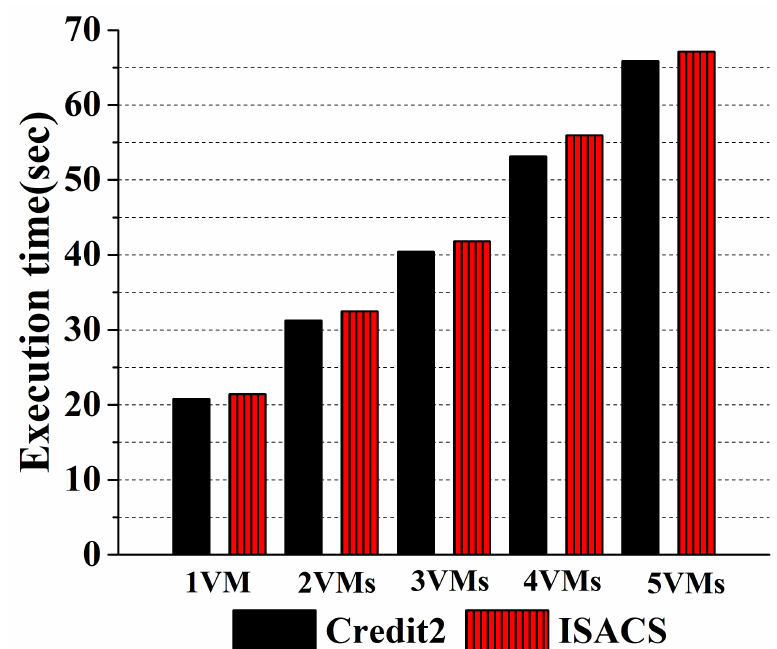
Figure 15. Average execution time of target-VM for 15 experiments according to the VM configuration in the mixed